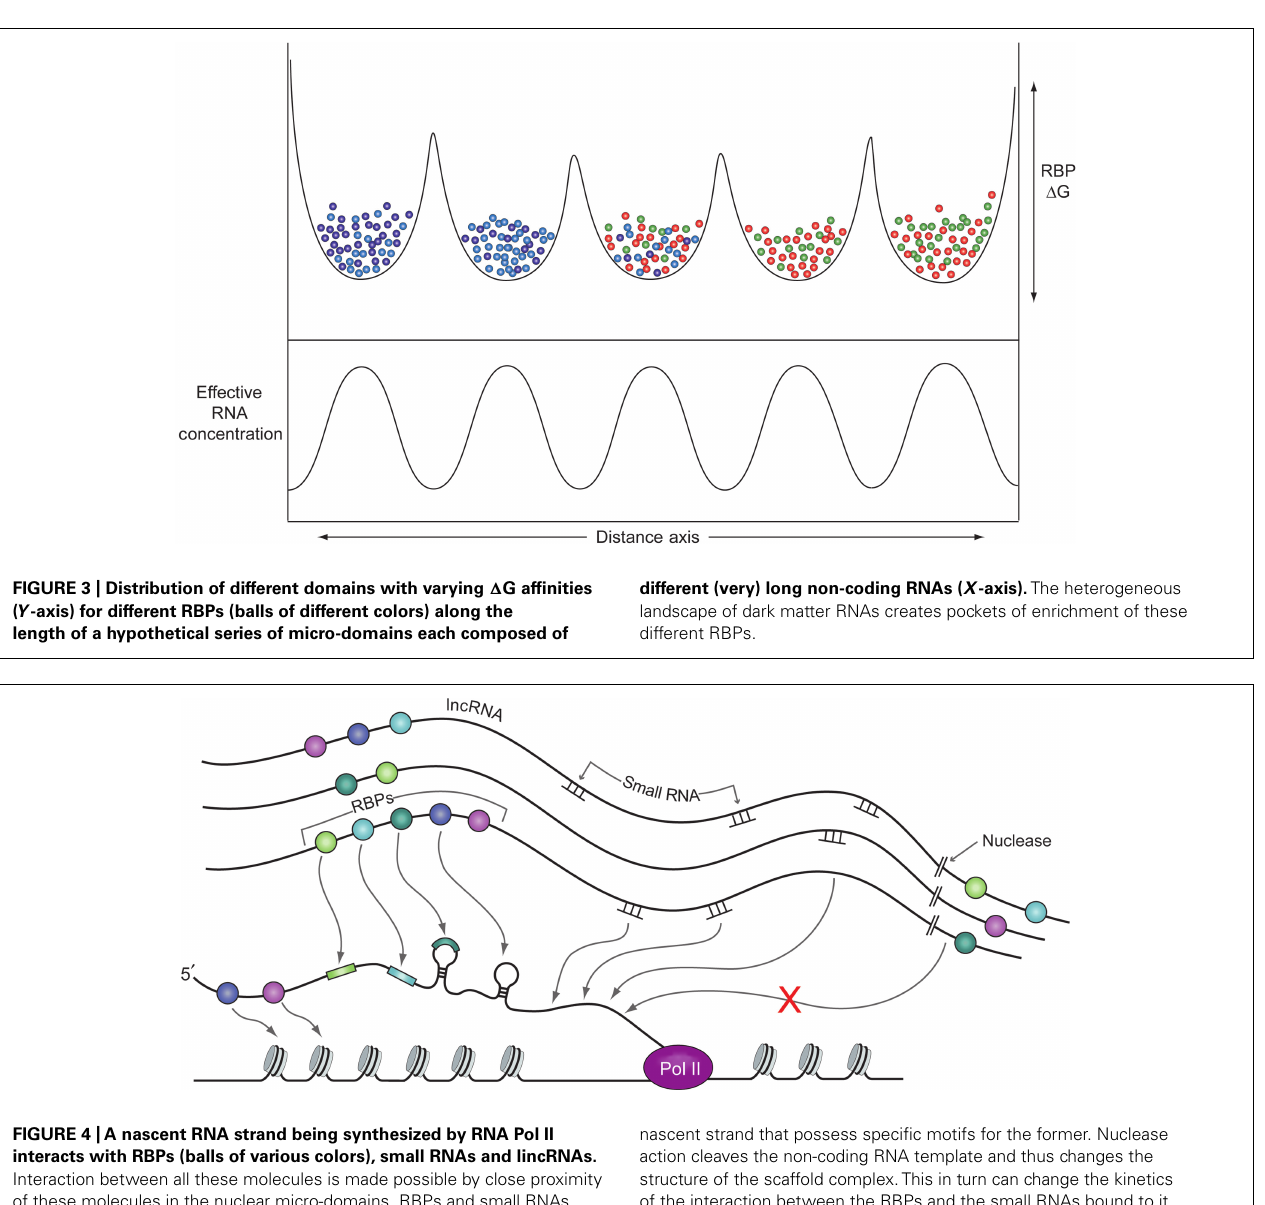
FIGURE 4 |A nascent RNA strand being synthesized by RNA Pol II interacts with RBPs (balls of various colors), small RNAs and lincRNAs. Interaction between all these molecules is made possible by close proximity of these molecules in the nuclear micro-domains. RBPs and small RNAs are bound to (v)lincRNAs with relatively low specificity and the latter present them in exact architectural and temporal environment to the